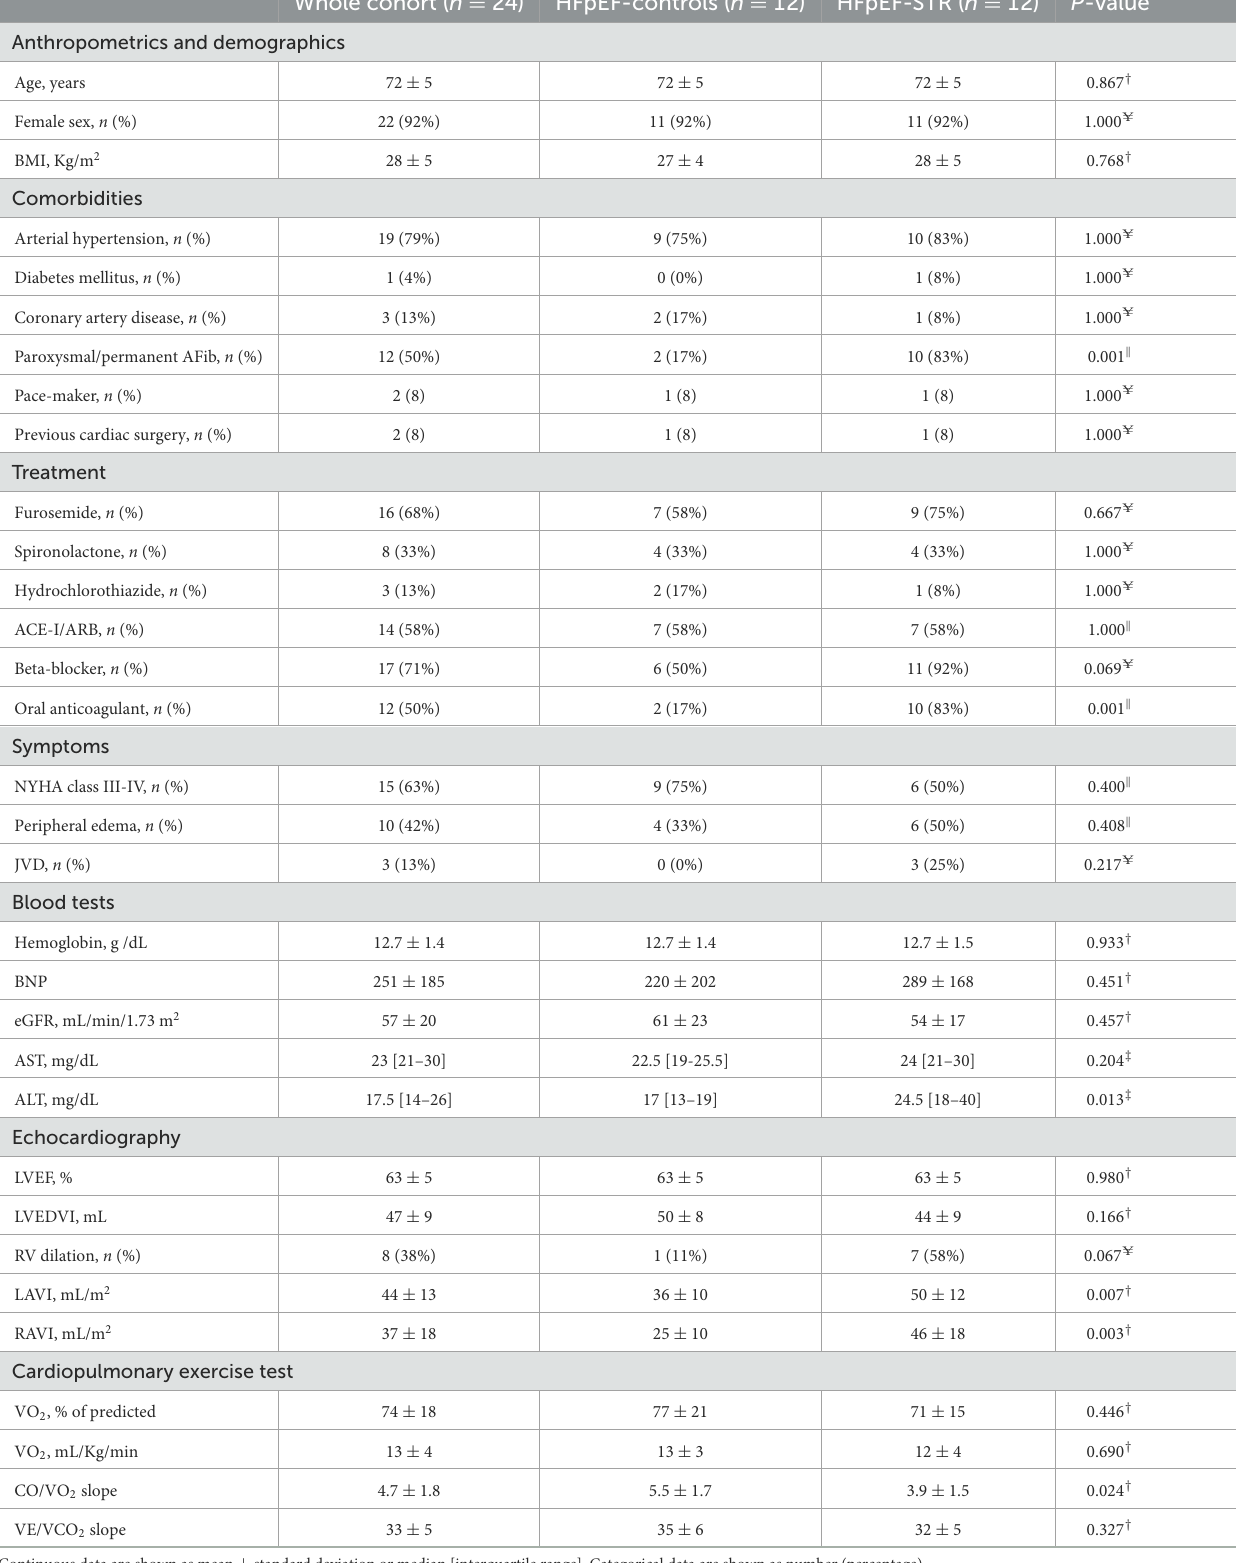
TABLE 1 Clinical characteristics of the study cohort. Whole cohort ( n =